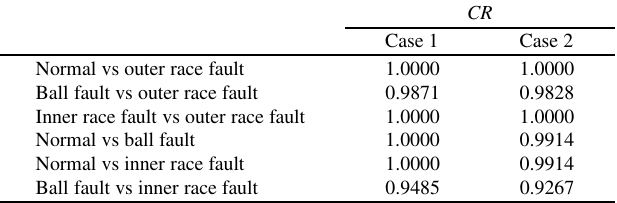
Table 2 CR values of the sub-classifiers for every two classes of multi-class LSSVM